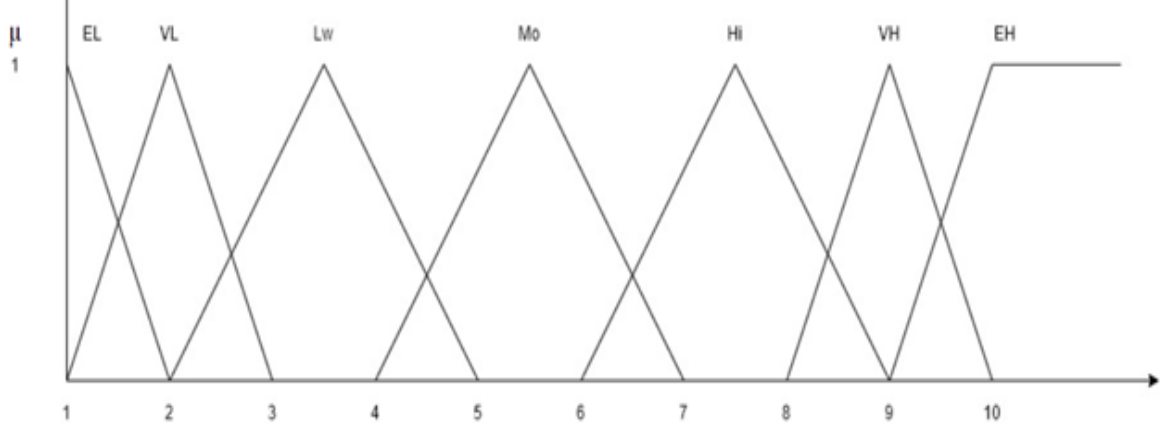
Figure 5. Fuzzy triangular membership functions for INSP.